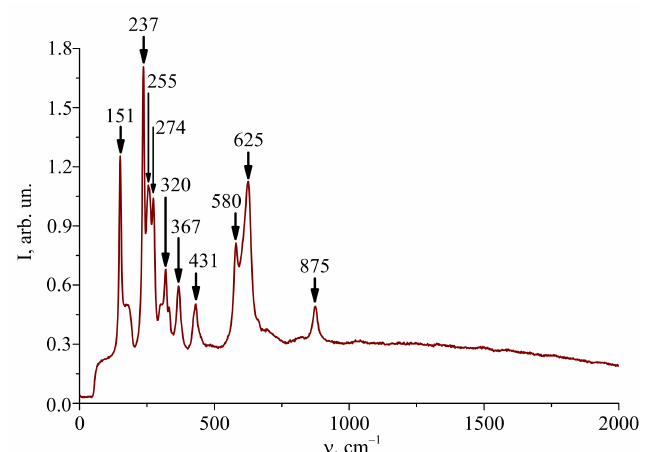
Figure 2. Raman spectrum of the LiNb 0.99 Ta 0.01 O 3 ceramic solid solution for the backscattering